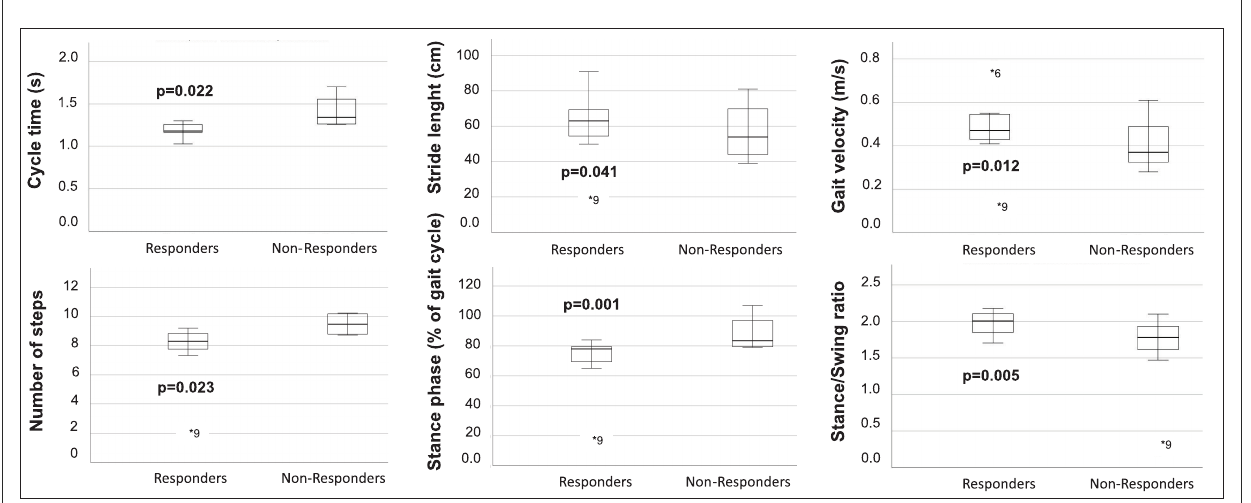
FIGURE3 Boxplots of the gait parameters that were statistically significant between responders (NPH-RR ≥ 5) and non-responders to VP-shunt implantation. Respective p -values are stated in bold face. Each plot indicates the absolute difference between the parameter’s median values for each group. Within each boxplot, the group’s median value is indicated as a line, and outliers are indicated as dots